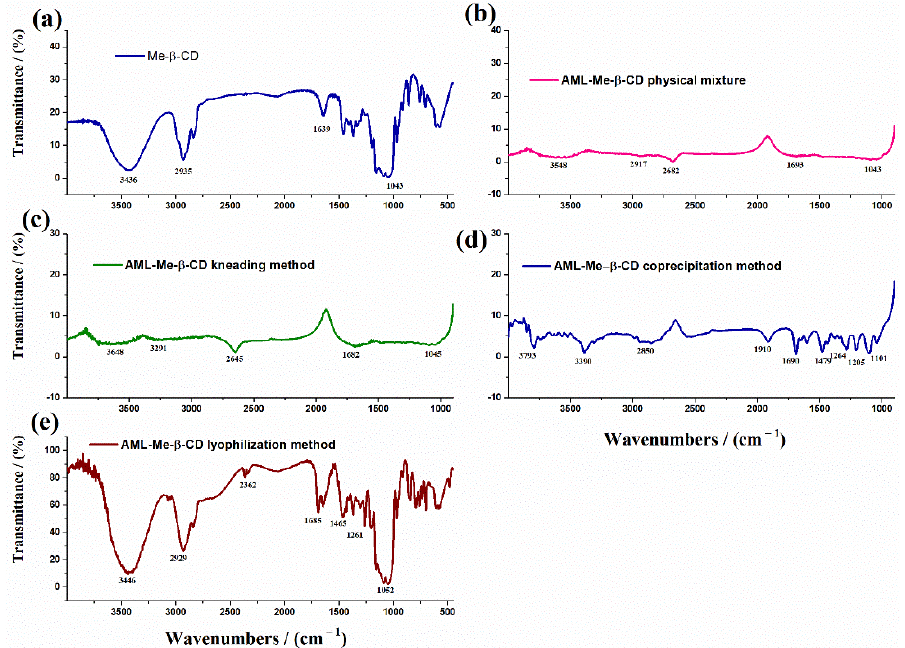
Figure 2. FTIR spectra of ( a ) Me- β -CD, ( b ) AML-Me- β -CD physical mixture, ( c ) AML-HP- β -CD kneading method, ( d ) AML-HP- β -CD coprecipitation method, and ( e ) AML-HP- β -CD lyophiliza- tion method.